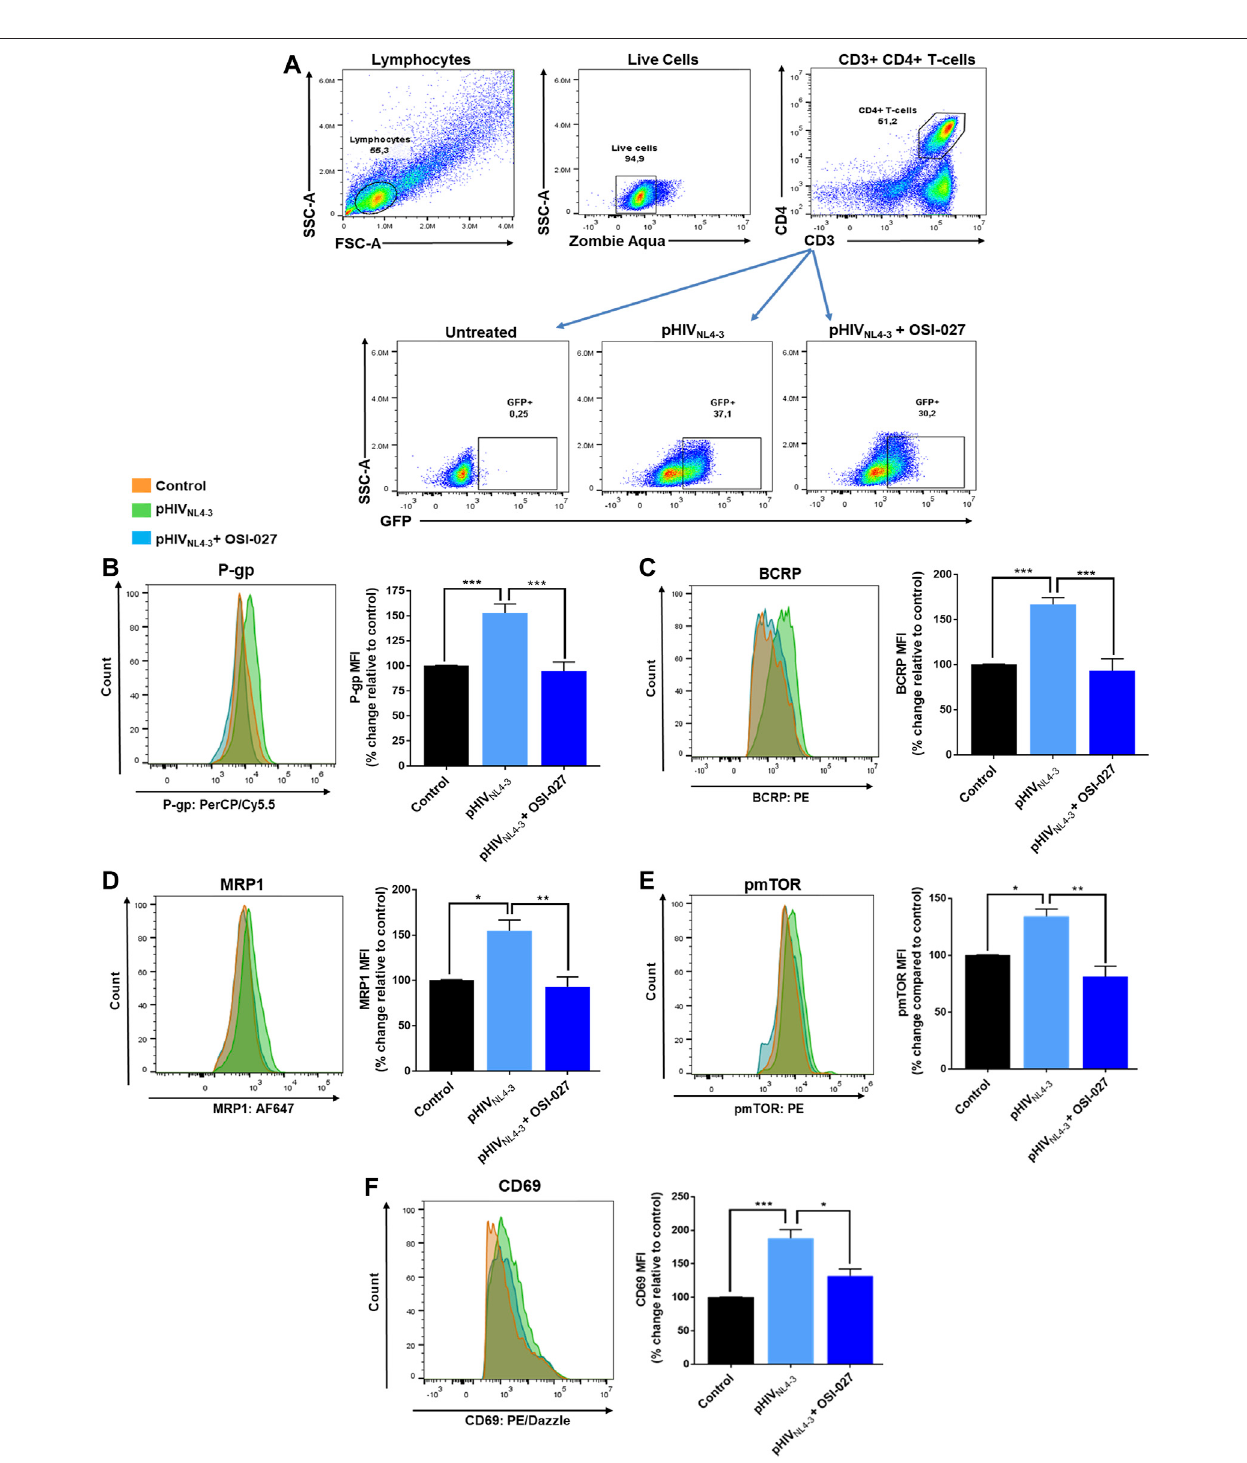
FIGURE3| mTORinhibitorOSI-027reversespHIV NL4-3 -mediatedinductionoftransporterexpression. (A) RepresentativegatingstrategyforCD4 + T-cellsisolated from PBMCs; panels from left to right show lymphocytes selected based on light scattering properties, viable (negative for Zombie Aqua) single cells were then selected for CD3 + CD4 + expression. The expression of GFP is shown in untreated, pHIV NL4-3 and/or OSI-027 (25 µM) treated CD4 + T-cells after 48 h exposure. (B – F) Representative histograms (left) and corresponding bar charts (right) are shown. Results are shown as mean percent change ± SEM in the expression (MFI) of P-gp (B) , BCRP (C) , MRP1 (D) , pmTOR (E) and CD69 (F) in untreated (vehicle control), pHIV NL4-3 , and/or OSI-027 treated CD4 + T-cells. Statistical analyses were performed using one-way ANOVA with Bonferroni ’ s multiple comparisons test; p < 0.05 was considered statistically signi fi cant, n (cid:2) 3 – 4 donors. *, p < 0.05; **, p < 0.01; ***, p < 0.001.